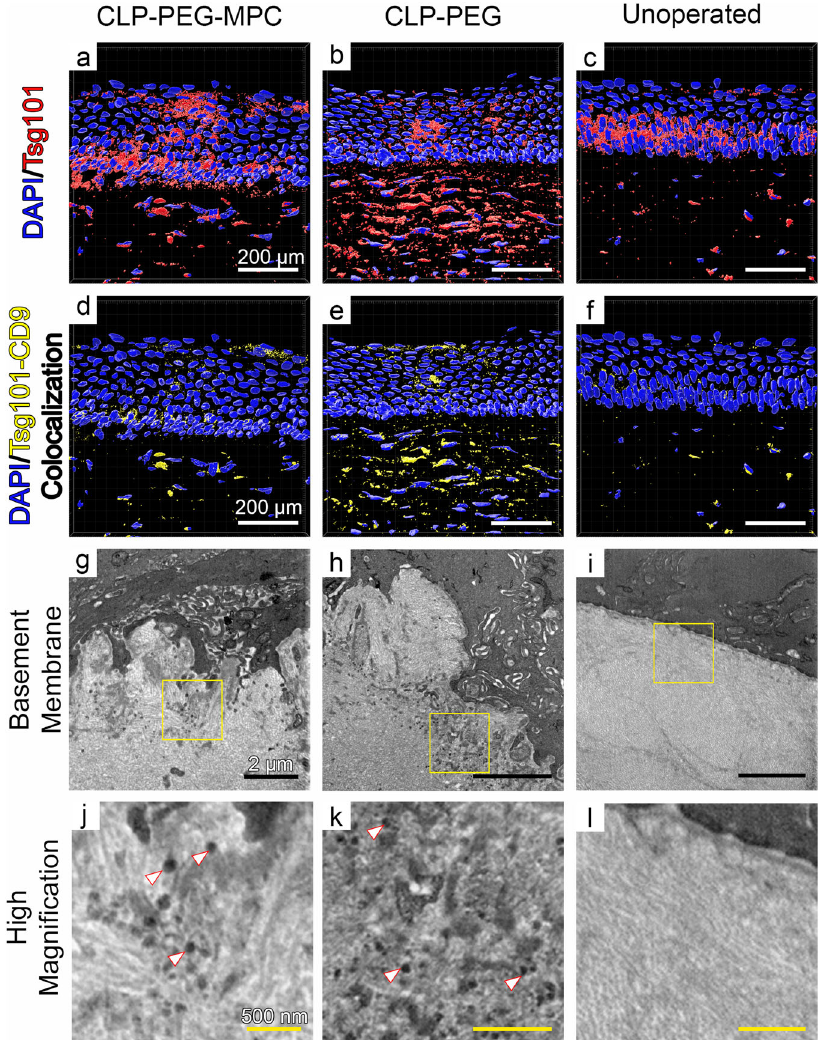
Fig. 8 Extracellular vesicles and exosome secretion by regenerating CLP-PEG-MPC and CLP-PEG implanted corneas. a – c Greater amounts of Tsg101 + EVs (red staining) were present in the grafted regions, with the highest level of secretion in the CLP-PEG implants compared to CLP-PEG-MPC implants and unoperated controls. DAPI (blue staining) was used to identify the cell nuclei. d – f CLP-PEG implants also had the highest amount of Tsg101 + , CD9 + exosomes represented by yellow staining. White scale bars, 200 µ m. g – i High resolution TEM of the basement membrane con fi rms the increased release of exosomes from the epithelium into the stroma. Black scale bars, 2 µ m. j – l High magni fi cation of the inset yellow-boxed areas showing the presence of exosomes (white arrowheads) in the stroma. Yellow scale bars, 500